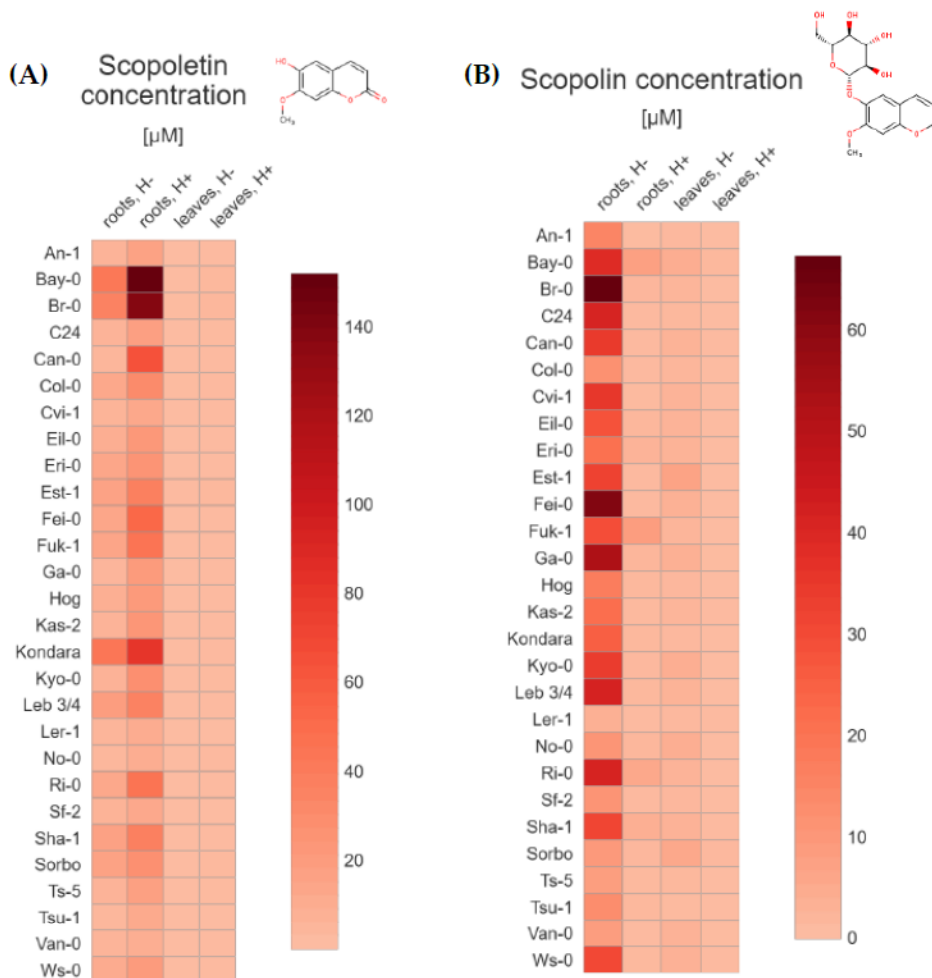
Figure 2. Heat maps based on the average ( A ) scopoletin and ( B ) scopolin concentration ( µ M/FW) in Arabidopsis tissue extracts from roots and leaves, without and after hydrolysis. The values used in the plots (https://app.displayr.com (accessed on 20 January 2021)) are the mean of 3 biological replicates. The mean values and standard deviations ( ± SD) are gathered in the supplementary materials (Table S1).